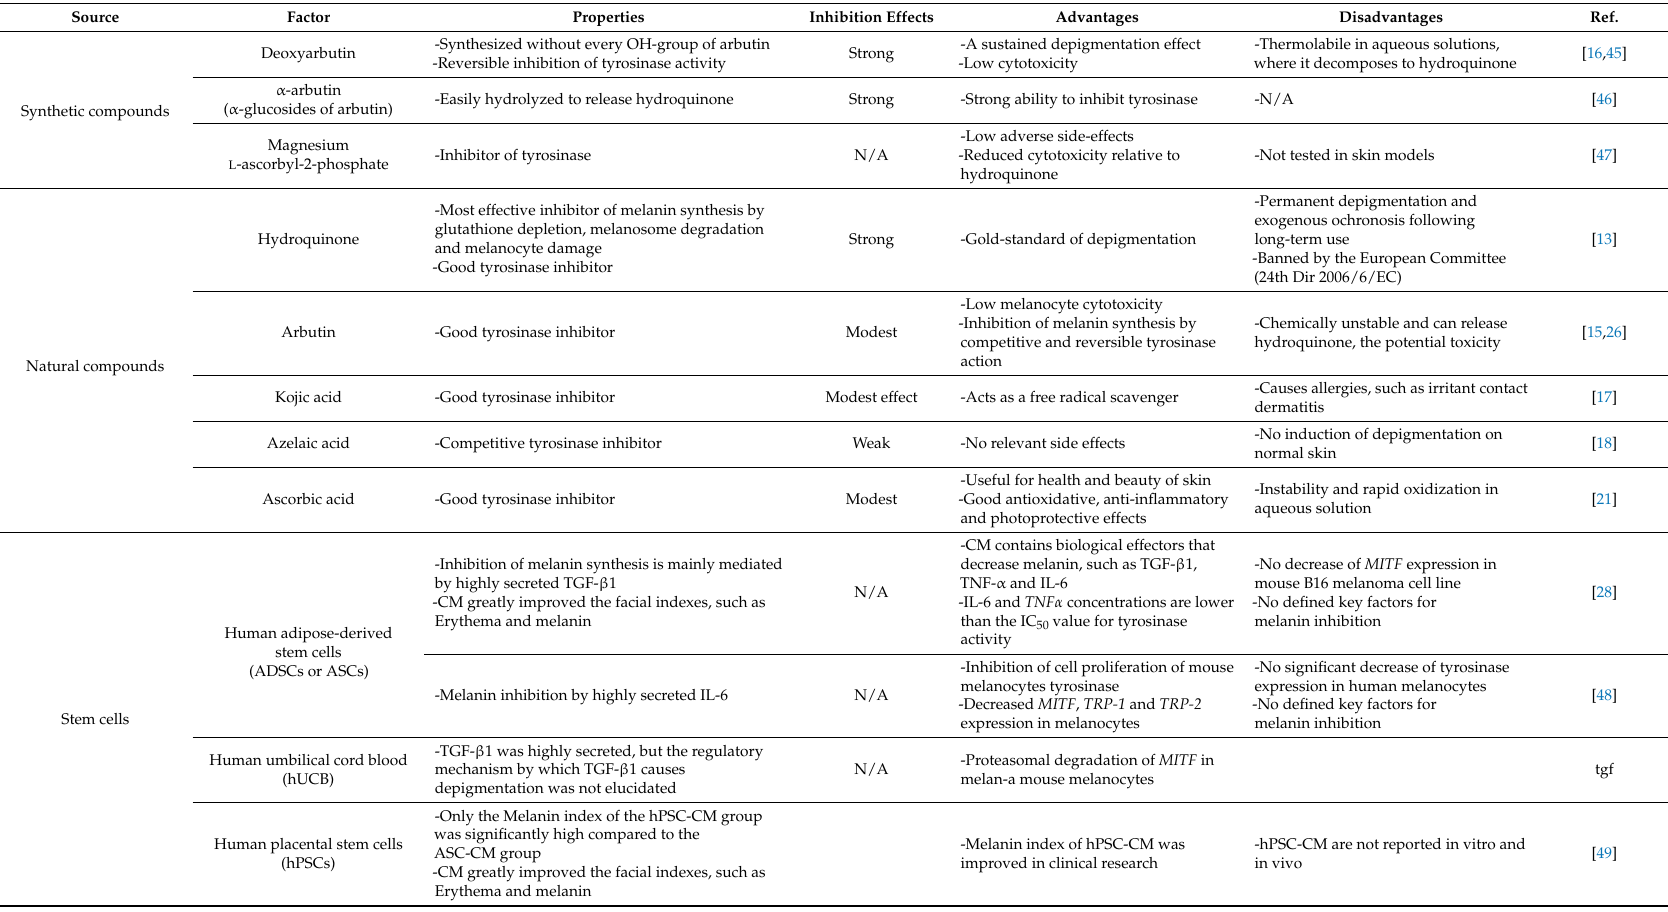
Table 1. Factors inhibiting melanin production and their